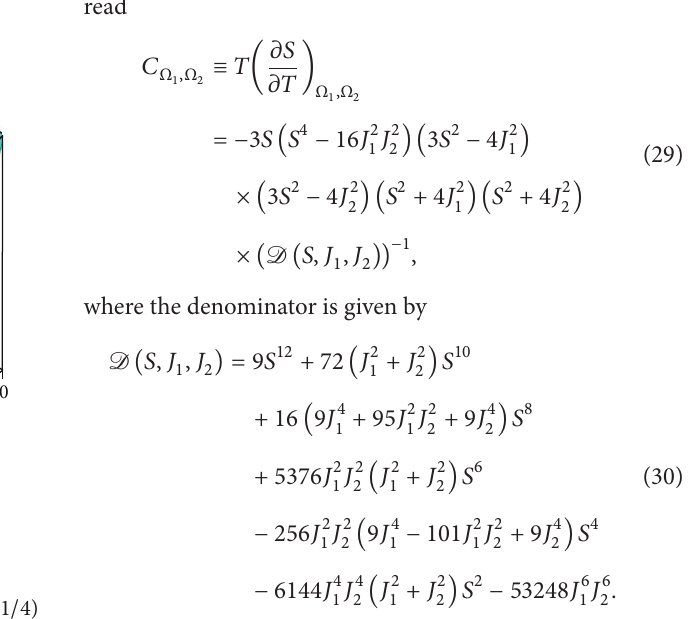
Figure 1: The difference between the extremal limit ( 𝐽 1 𝐽 2 /𝑆 2 = 1/4 ) and the value of 𝐽 1 𝐽 2 /𝑆 2 at the critical point of the heat capacity, plotted for values of 𝐽 1 and 𝐽 2 in the interval [0, 10]